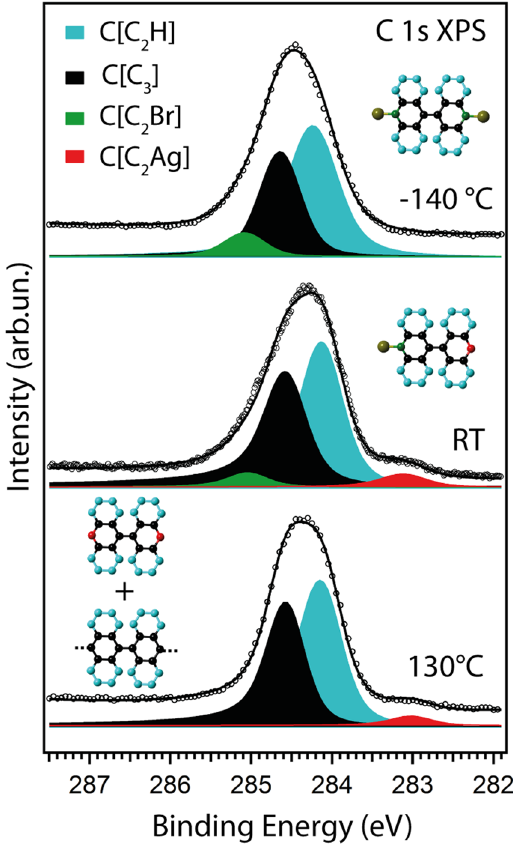
Figure 2. C 1s XPS spectra for DBBA/Ag(111) at − 140 °C (top), at RT (middle) and after annealing up to 130 °C (bottom). Corresponding structural models are shown as insets. The photon energy is 380